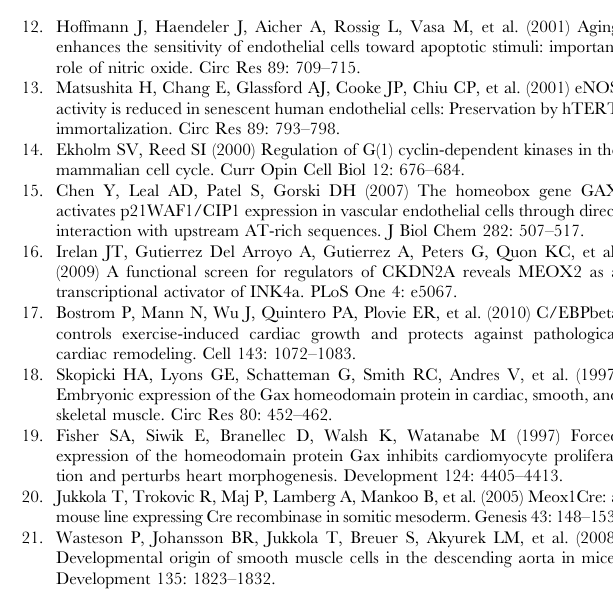
Table S3 List of PCR primers used for qRT-PCR. Table S4 List of EMSA